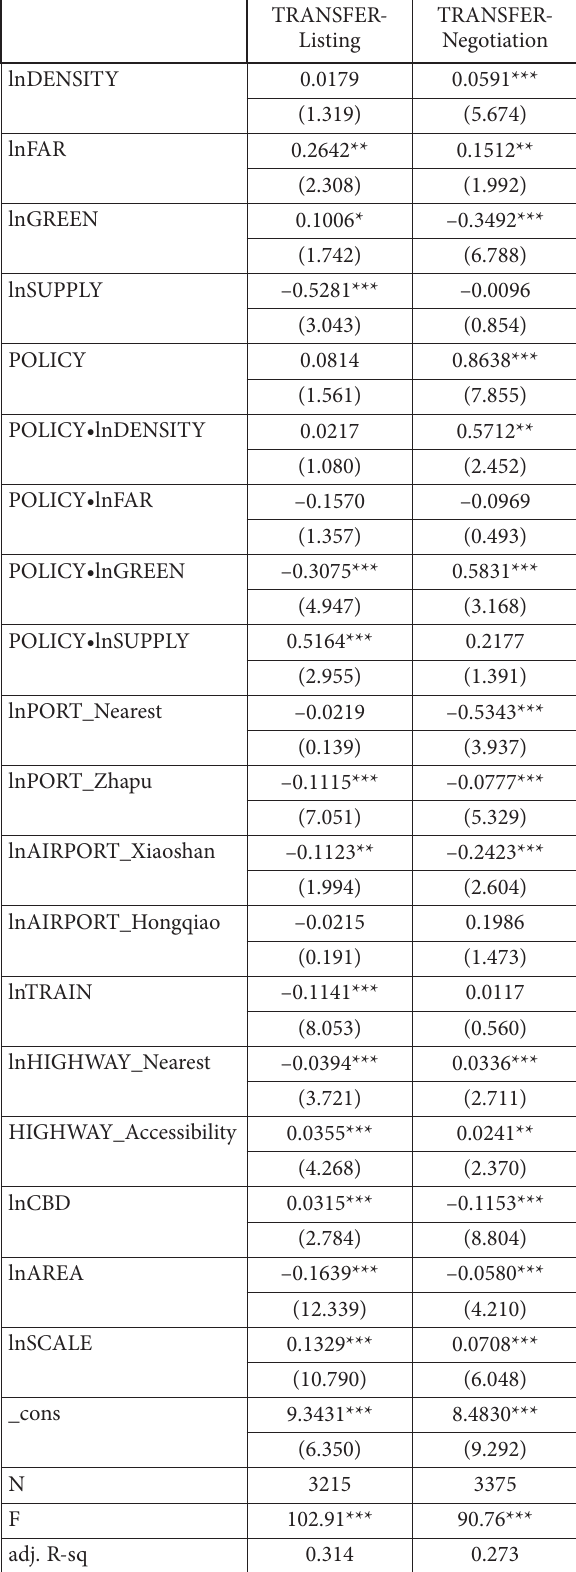
Table 3. Results of the regression model of the impact of land use regulation on industrial land price with consideration